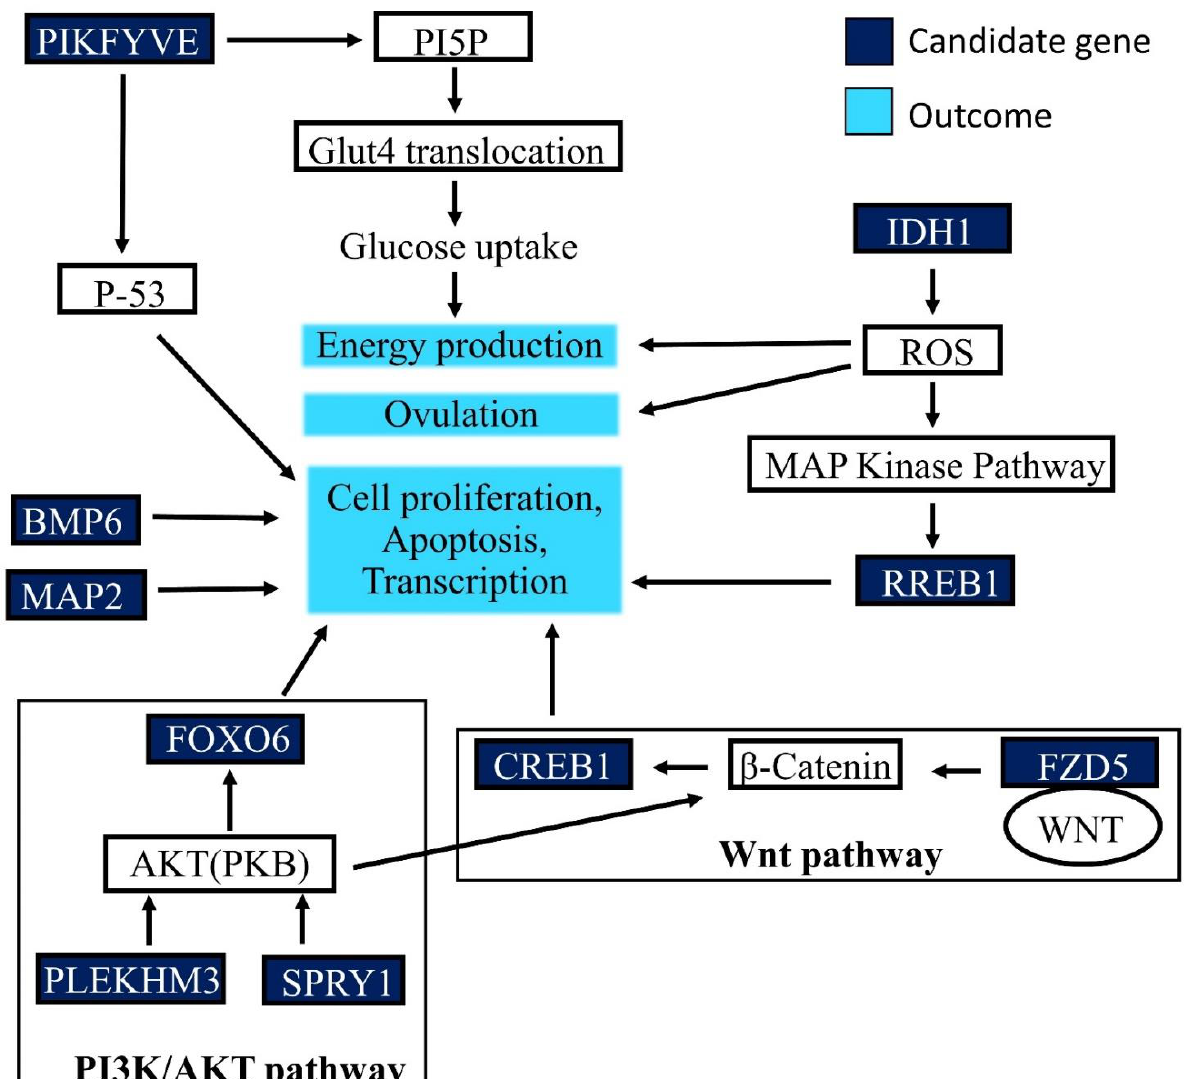
Figure 6. Proposed pathway(s) for the candidate genes in regions of the significant SNPs associated with antral follicle count (AFC). Arrows indicate an effect not increasing or decreasing.